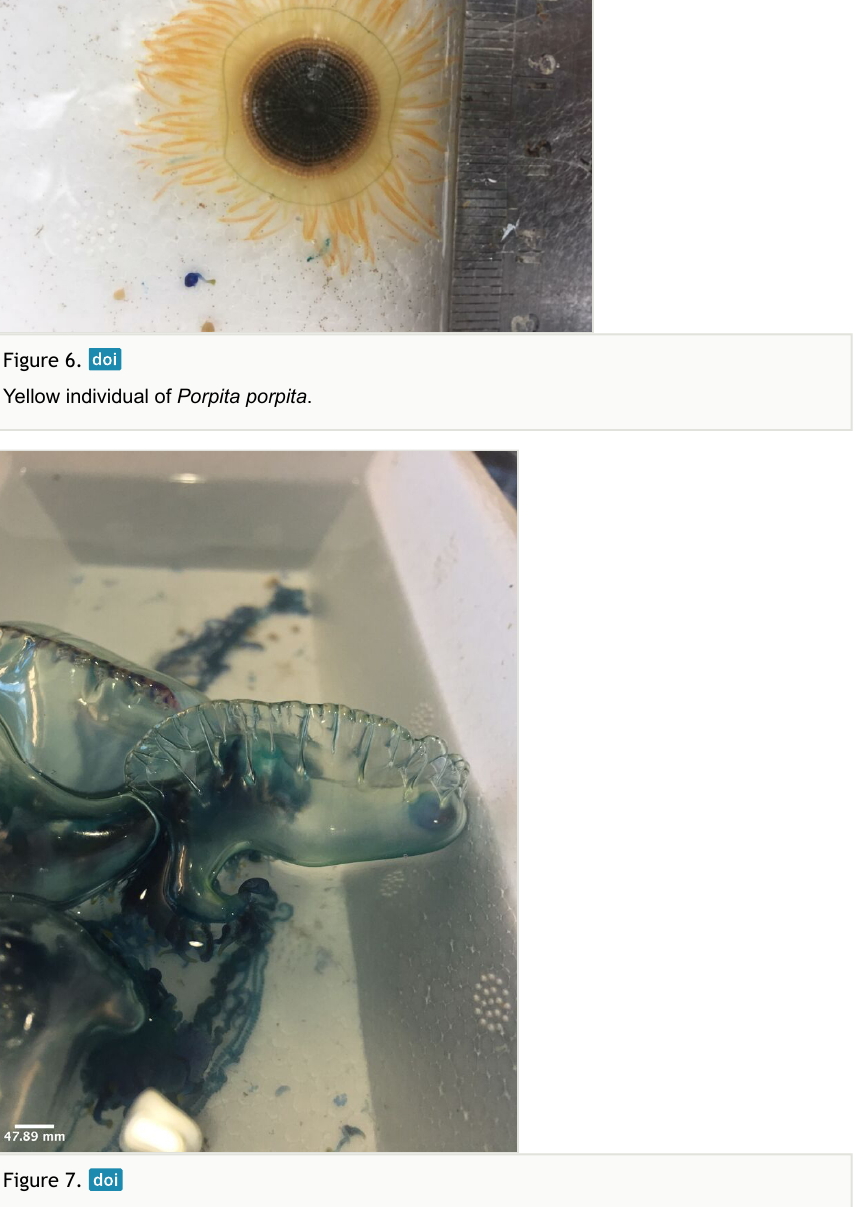
Figure 7. Physalia physalis washed ashore in Semawang Beach, Denpasar City, Bali Island. Note the lateral view with the pneumatophore (gas-filled float) and zooids attached to the ventral